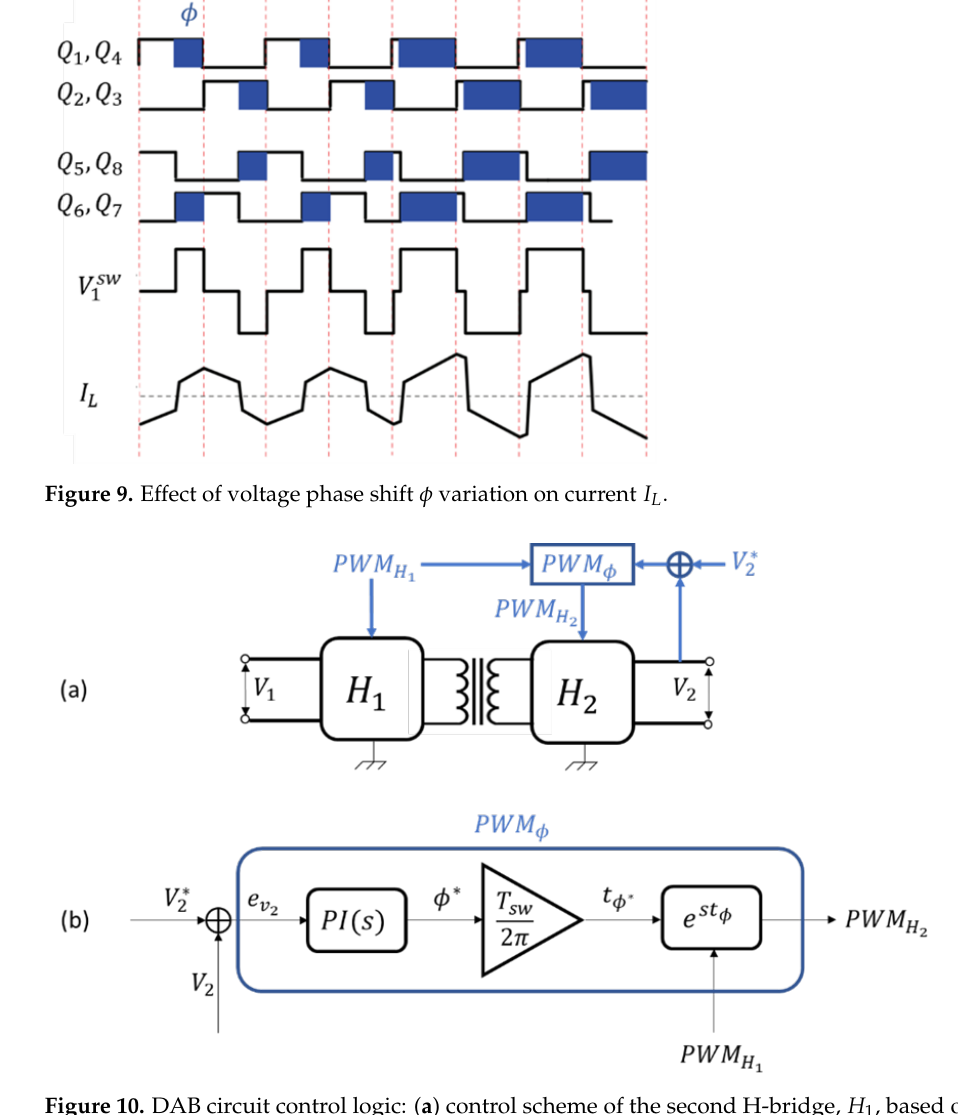
Figure 10. DAB circuit control logic: ( a ) control scheme of the second H-bridge, H 1 , based on time shift with respect to the first H-bridge, H 2 ; ( b ) block diagram of the PWM φ modulation